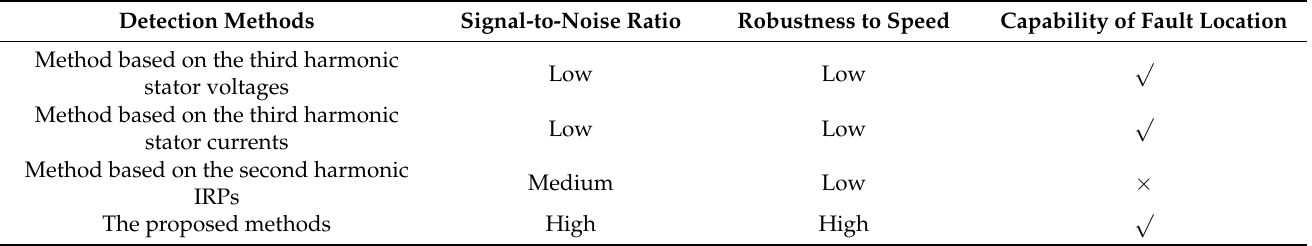
Table 4. Comparison of Advantages and Disadvantages of ITSC Detection